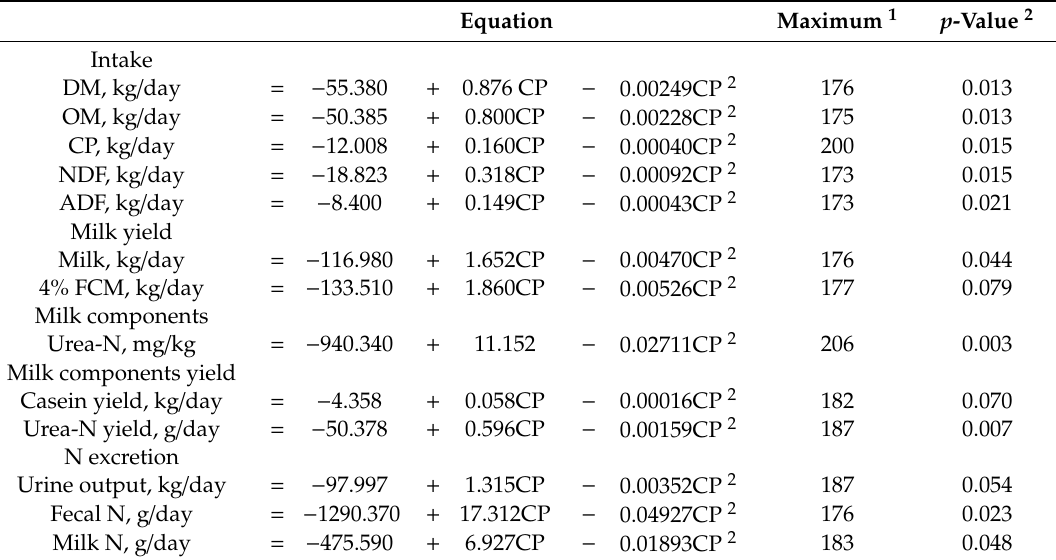
Table 6. Quadratic regression equations of dietary CP level (g / kg